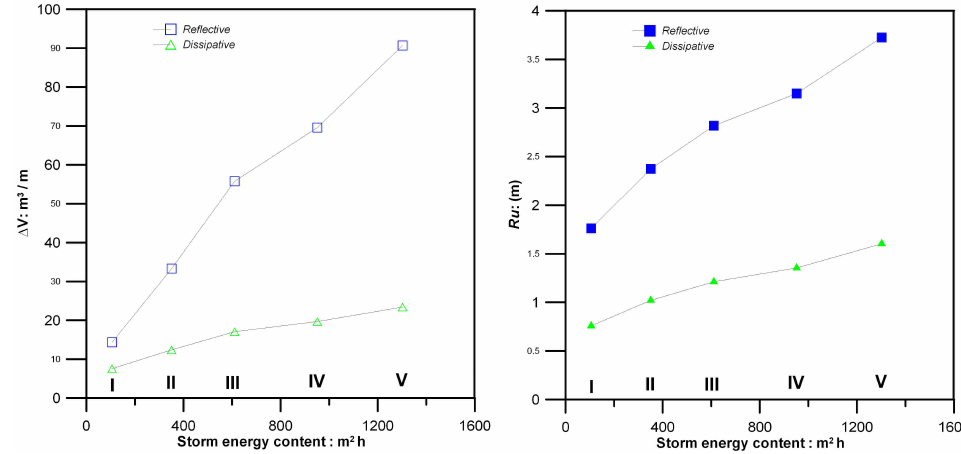
Fig. 8. Magnitude of storm-induced coastal hazards in representative beaches of the Catalan coast (left: beach profile erosion, right: wave